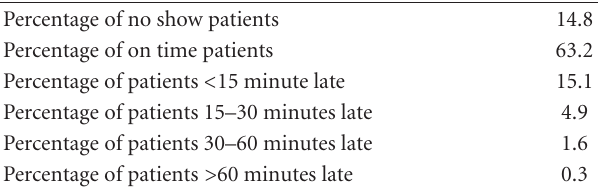
Table 2: Patients stratified by arrival time compared to scheduled appointment